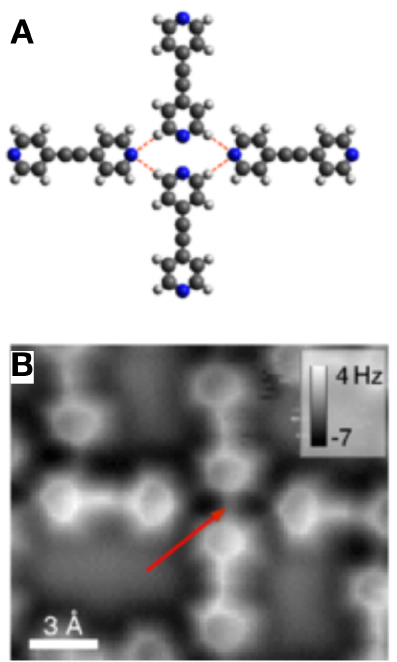
Figure 15. Bis(parar-pyridyl)acetylene (BPPA) molecules. ( A ) Schematic of the tetramer. ( B ) AFM im- age of the tetramer taken with a CO terminated tip showing apparent intermolecular bonds. Adapted with permission from American Association for the Advancement of Science from Figure 2 in